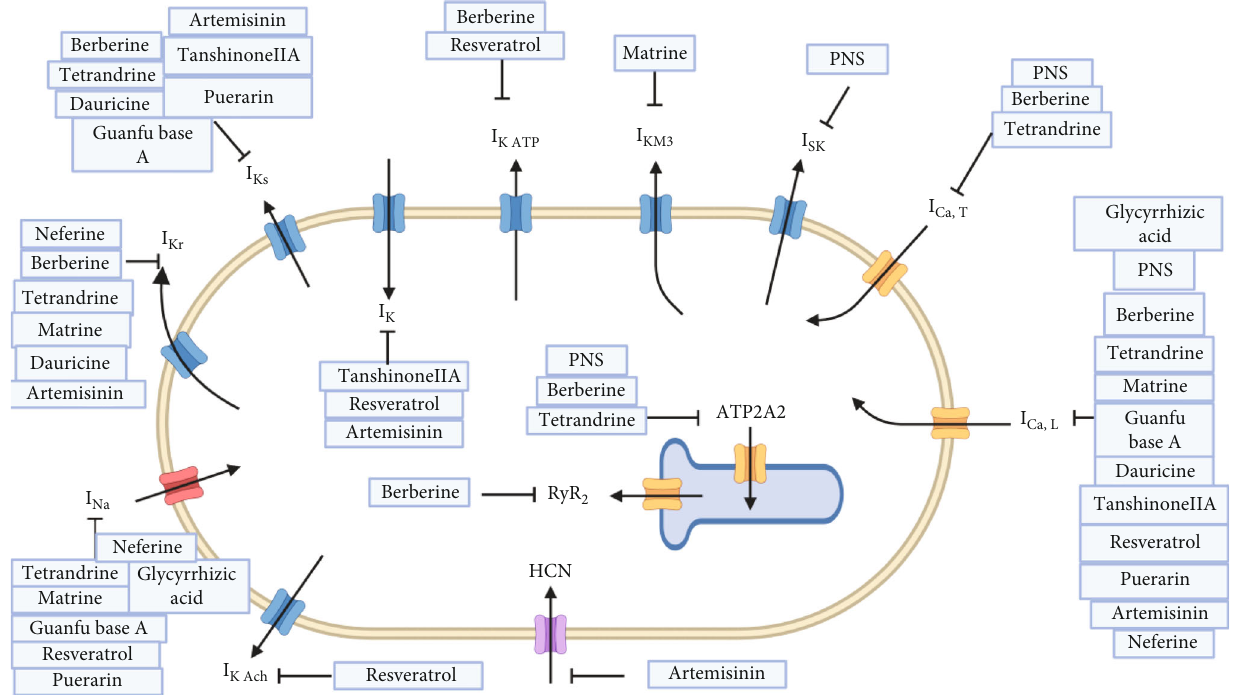
Figure 2: Natural products ’ e ff ects on potassium, sodium, and calcium